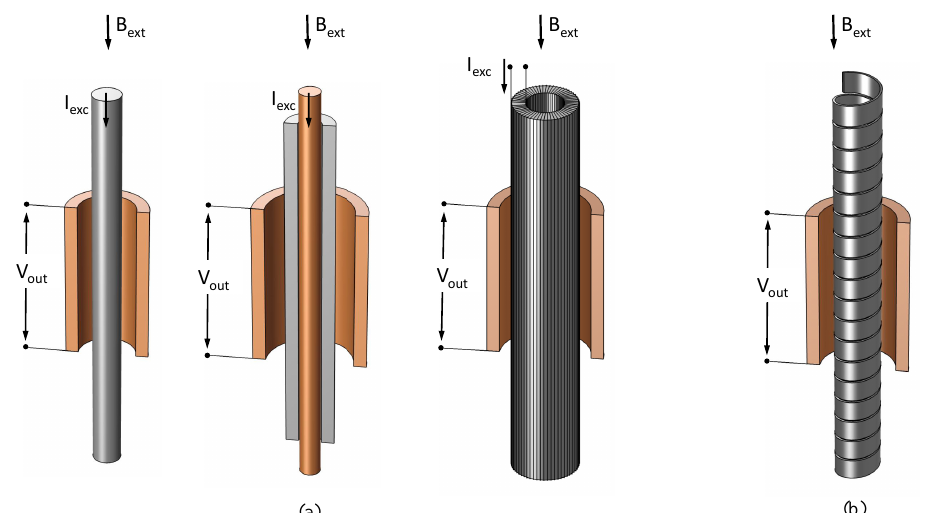
Figure 3. Orthogonal (( a ) Aldredge) and mixed-mode (( b ) Schonstedt) fluxgate configurations; in gray is the ferromagnetic core, and detection winding and solid excitation conductor are in orange (if